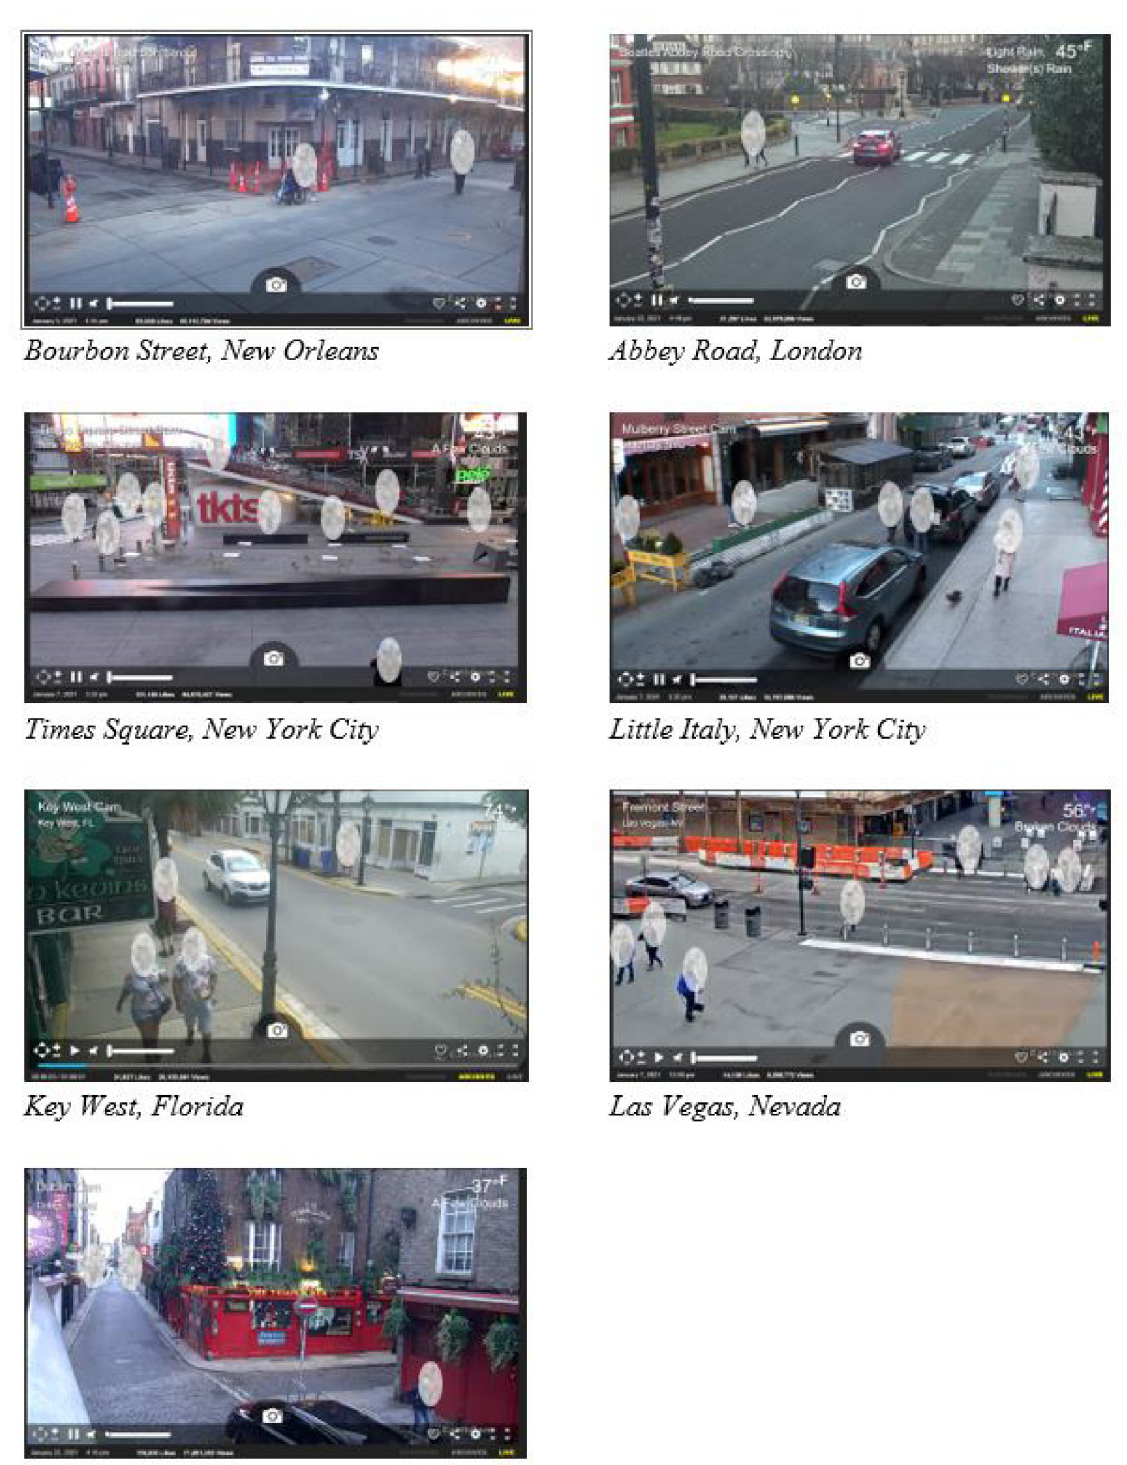
Fig 1. Livestream webcam